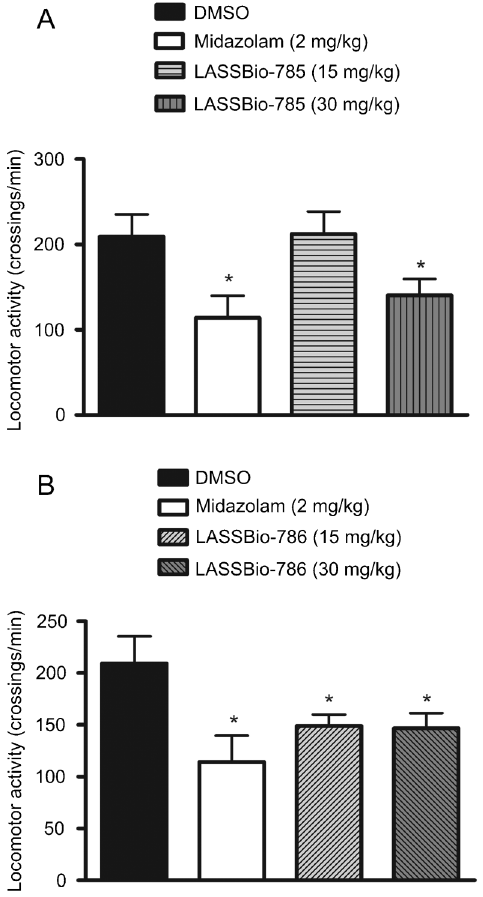
Figure 1. Effect of midazolam and two new N -acylhydrazone compounds on locomotor activity of mice. LASSBio-785 ( A ) and LASSBio-786 ( B ) were injected (15 and 30 mg/kg, ip), and locomotor activity was determined in an open field test during a 40-min period. Data are reported as means ± SE (n = 10). *P , 0.05 compared to DMSO (Dunnett multiple comparison